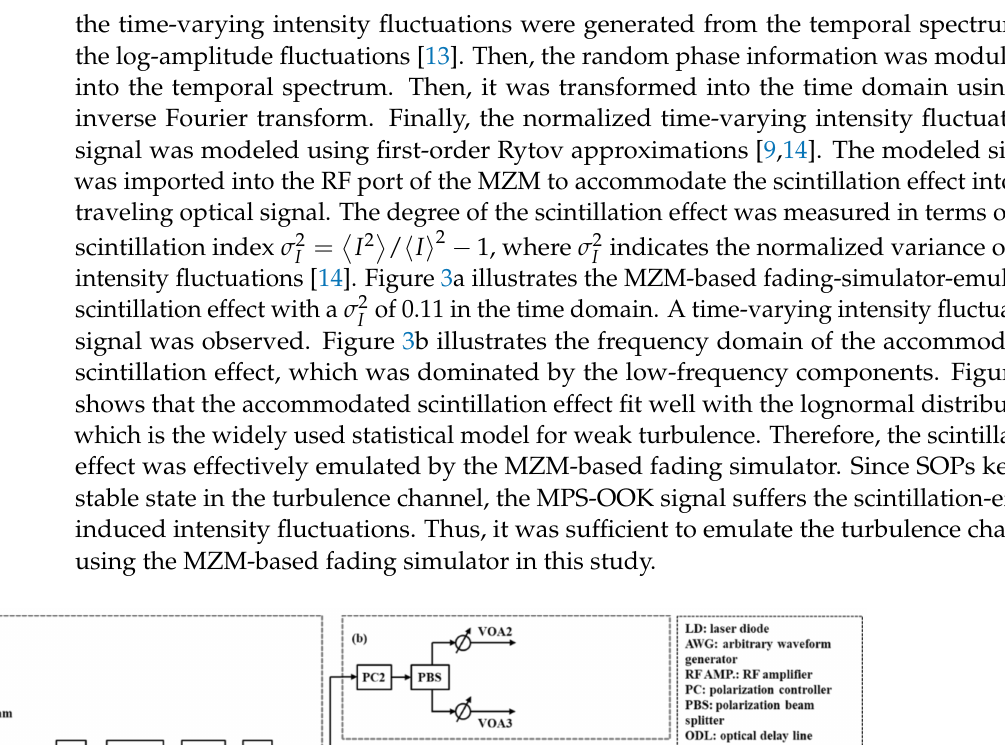
of 0.11: ( a ) time domain, ( b ) frequency I